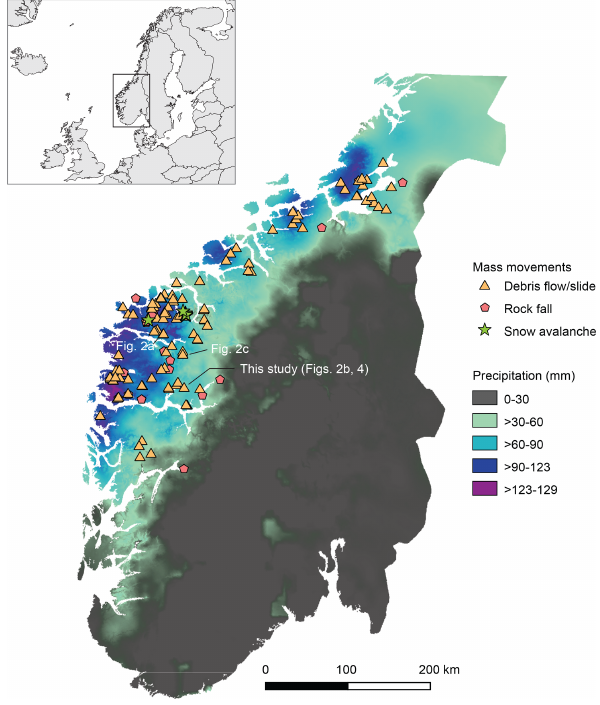
Figure 1. Mass movements that occurred on 15 and 16 Novem- ber 2013 during storm Hilde in Norway – 114 debris flows and slides, 28 rockfalls, and 7 snow avalanches. Data retrieved from the Norwegian landslide database: https://gis3.nve.no/link/?link= SkredHendelser (last access: 25 January 2019). Precipitation is in- terpolated from observations and shows the amount in millimeters (mm) in 24h, collected at 06:00UTC 16 November (07:00LT, local time); data were retrieved from http://www.xgeo.no/(last access: 21 March